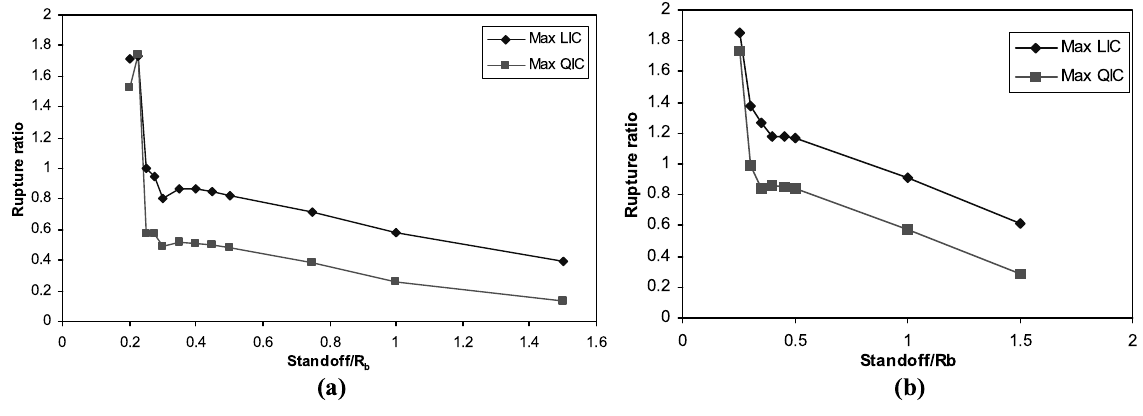
Fig. 10. Rupture ratios predict for 1.21 mm thick plates (a) A1008; (b) 350